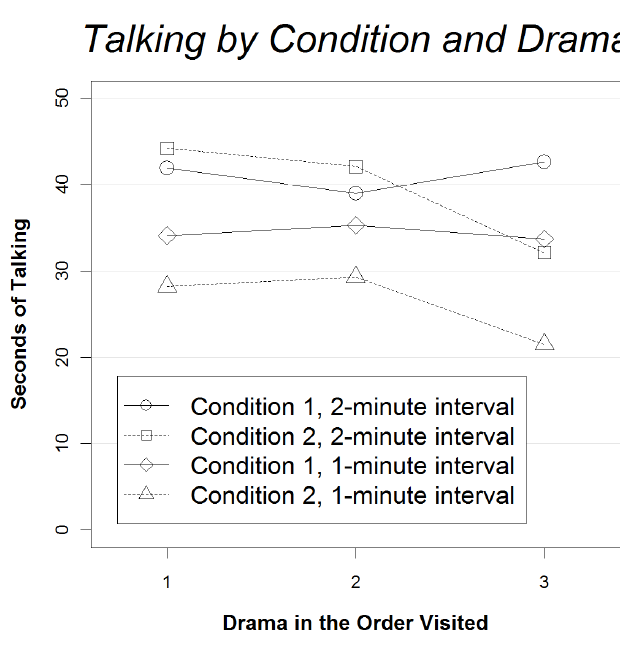
Figure 2. Talking change by